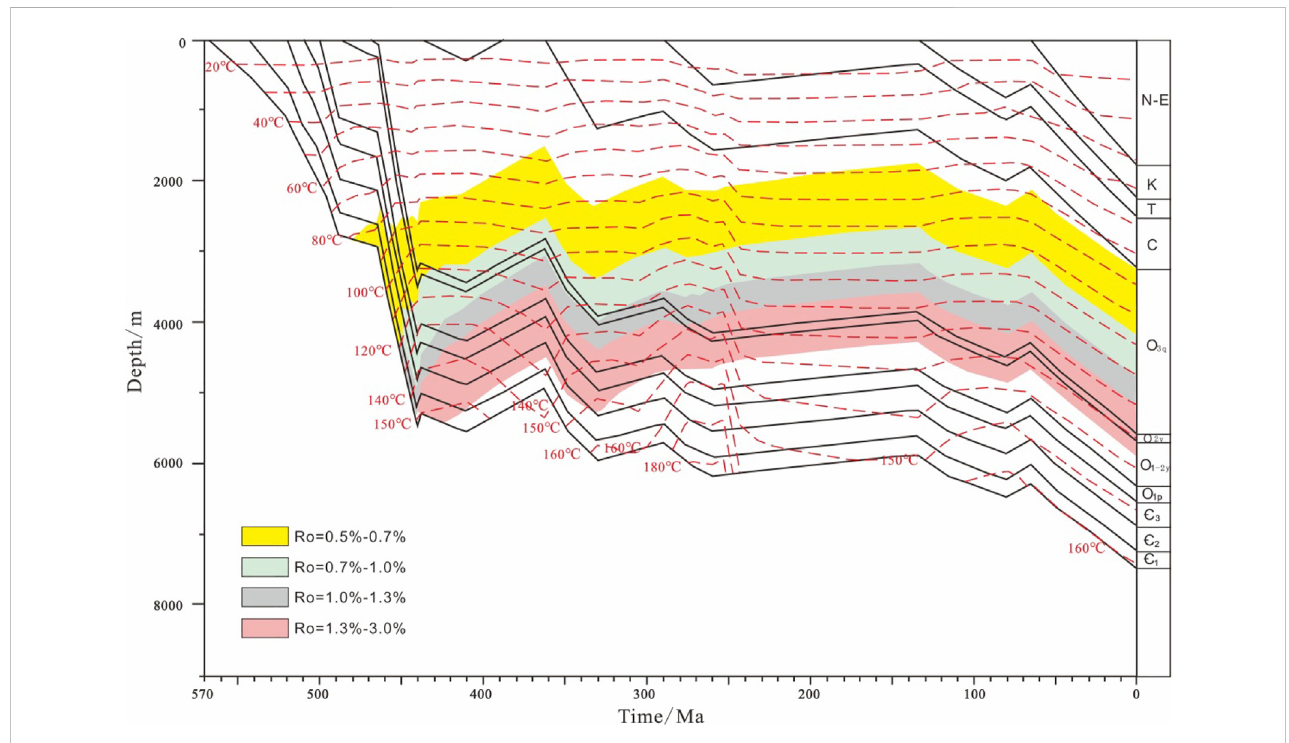
FIGURE 2 History of burial – thermal maturation of a typical well in Gucheng